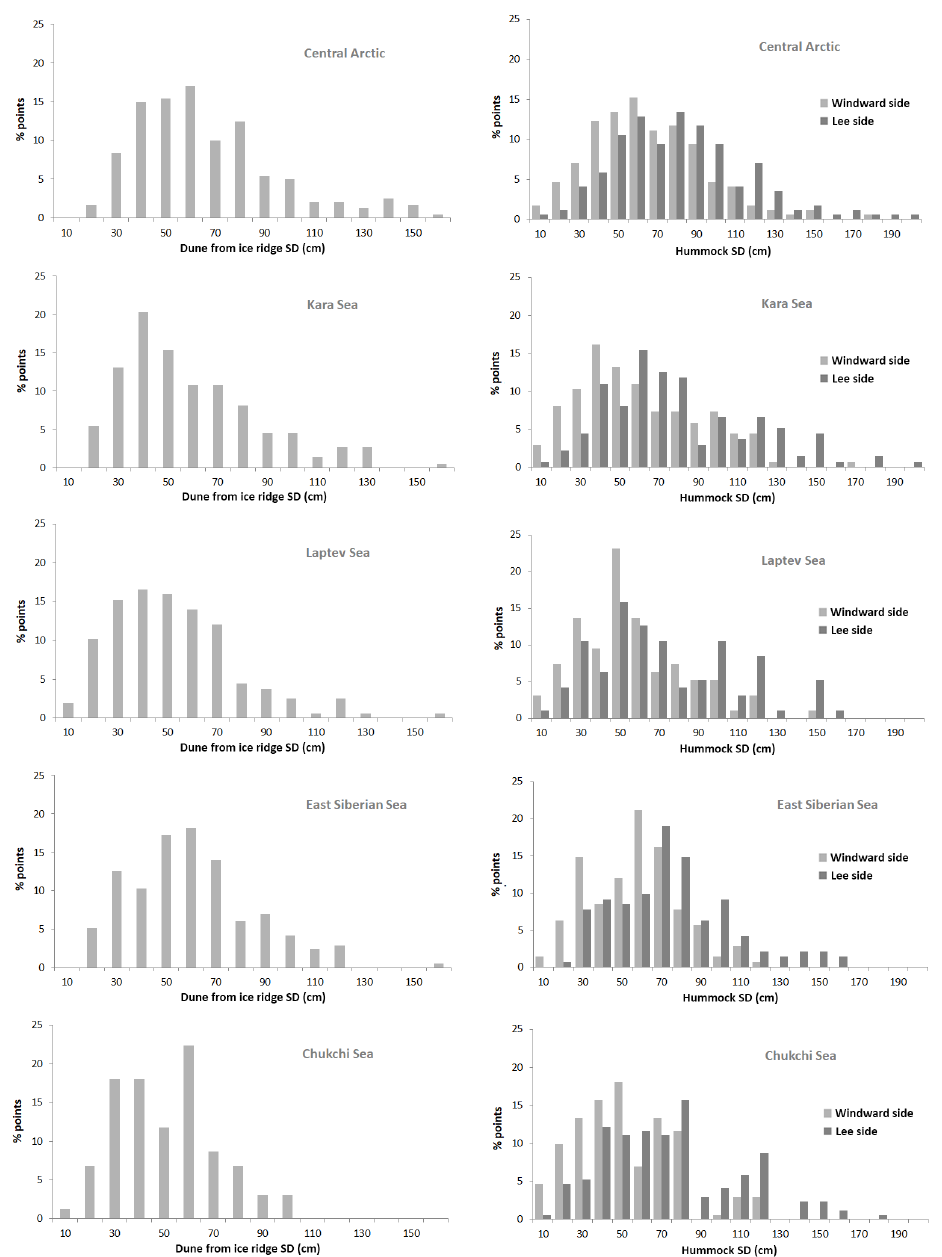
Figure 9. Distribution functions of snow depth (SD) in the dunes attached to ice ridges and around hummocks (on the windward and lee side) in different parts of the